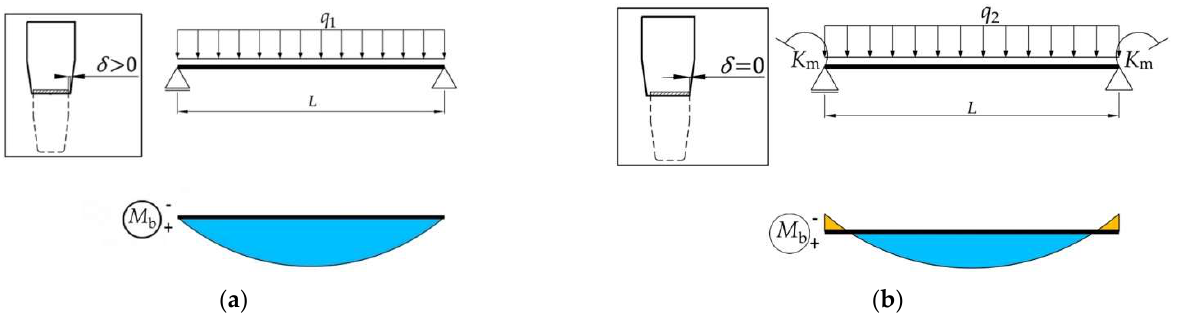
Figure 8. Beam design by considering the looseness effect of beam end connector: ( a ) the first step (pinned connections); ( b ) the second step (semi-rigid connections).